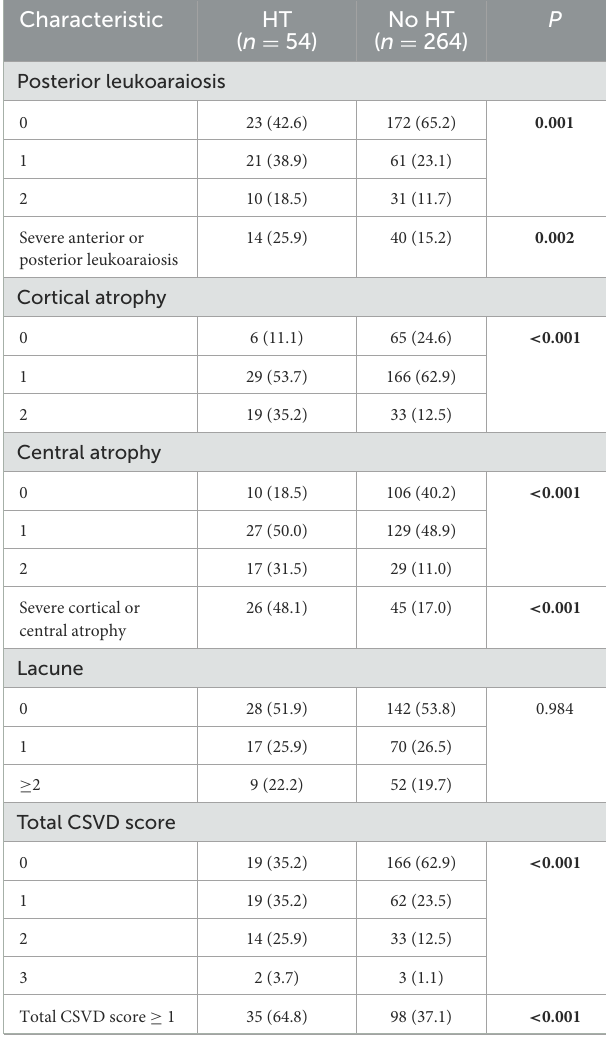
TABLE 2 Regression analysis to identify associations of clinicodemographic characteristics with risk of hemorrhagic transformation after intravenous thrombolysis a .